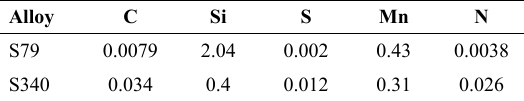
Table 1. Chemical composition (wt.%) for alloys S79 and S340.